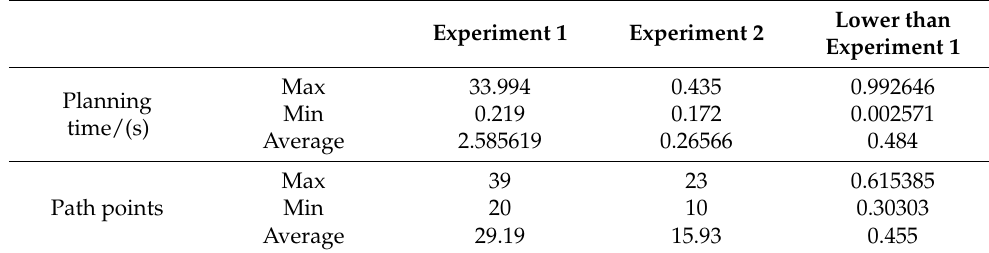
Table 4. The comparison between the